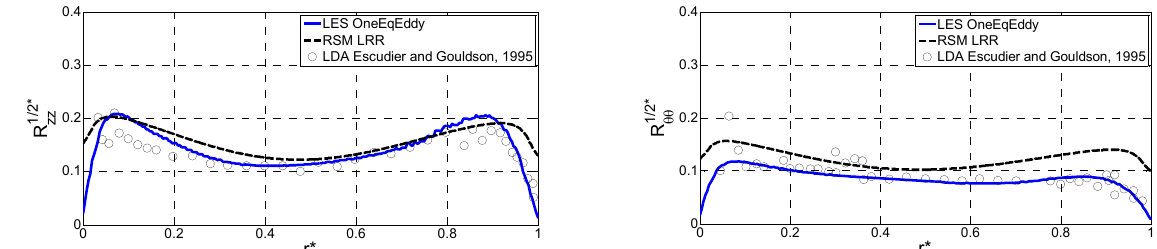
(cid:2873)∗ (cid:2873)∗ and (cid:1844) (cid:3053)(cid:3053)(cid:2868) . . Comparison between numeri ‐ and R 0.5 ∗ zz . Comparison between numerical θθ